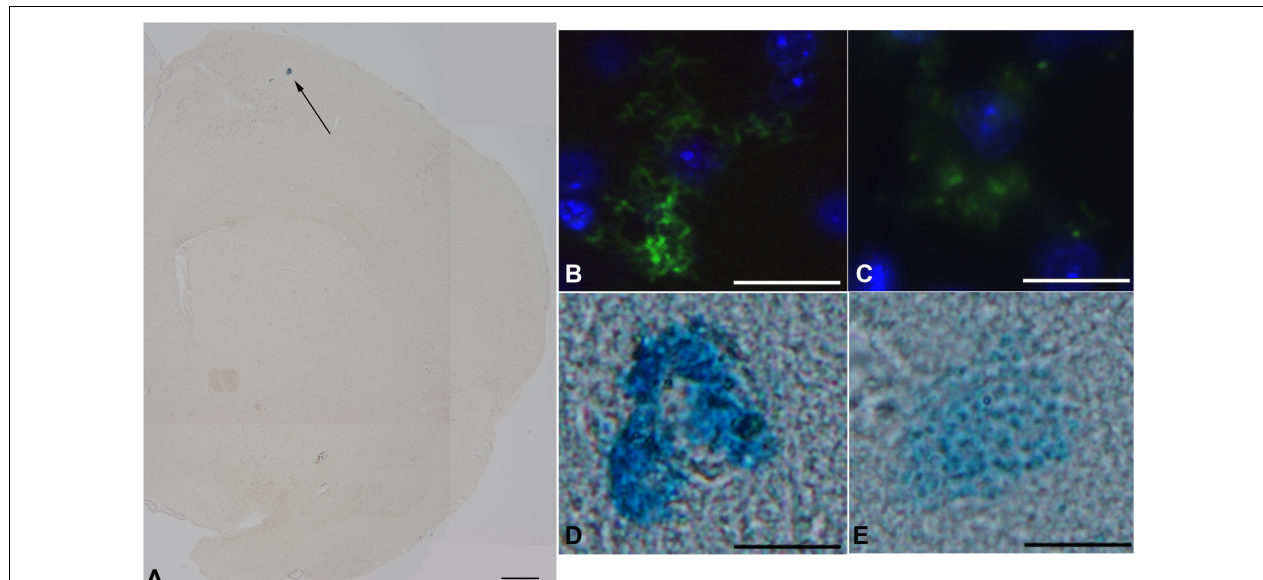
FIGURE 1 | The effect of TA1 on brain mast cell degranulation. Mast cells were stained as described in Methods. (A) Astra blue staining, representative image of a hemisphere. Few mast cells are visible in the upper portion (black arrows) 35x magnification; scale bar 600 µ m. (B,C) Representative images of mast cells exposed to Veh (picture B) or to 4 µ gkg − 1 TA1 (C) stained with FITC conjugated avidin (green). (D,E) Representative images of Astra blue stained mast cells exposed to Veh (D) or to 4 µ gkg − 1 TA1 (E) . 1000 × magnification; scale bar 100 µ m.